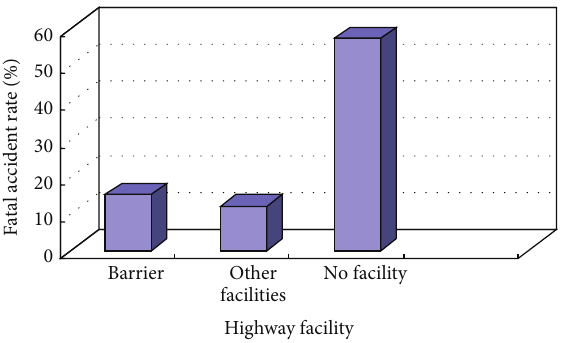
Figure 5: Fatal rate according to highway accident